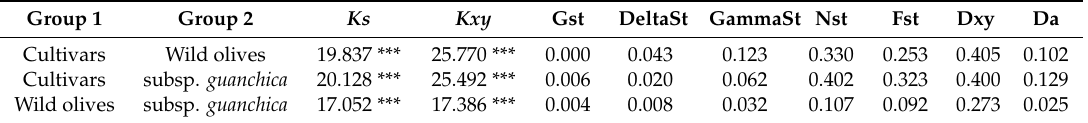
Table 1. Genetic di ff erentiation parameters between cultivars, oleasters, and subsp. guanchica samples detected by DnaSP